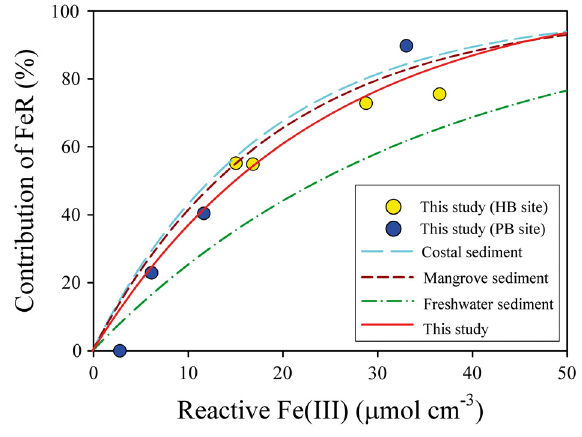
Fig. 5. Relative contribution of Fe(III) reduction (FeR) to anaerobic carbon oxidation as a function of reactive Fe(III) content in sediment. The red line shows the best fit of the data from Manila clam aquaculture sediment using Eq. (2) (Section 4.3) with a = 0.042. The blue line shows the general relationship of FeR to anaerobic carbon oxidation in coastal sediment using a = 0.056 as reported by Jensen et al. (2003). The brown line shows the relationship of FeR to anaerobic carbon oxidation in mangrove sediment using a = 0.053 (Kris- tensen et al. 2011). The green line represents the relation- ship of FeR to anaerobic carbon oxidation using a = 0.029 for freshwater wetlands (Roden & Wetzel 2002). HB: